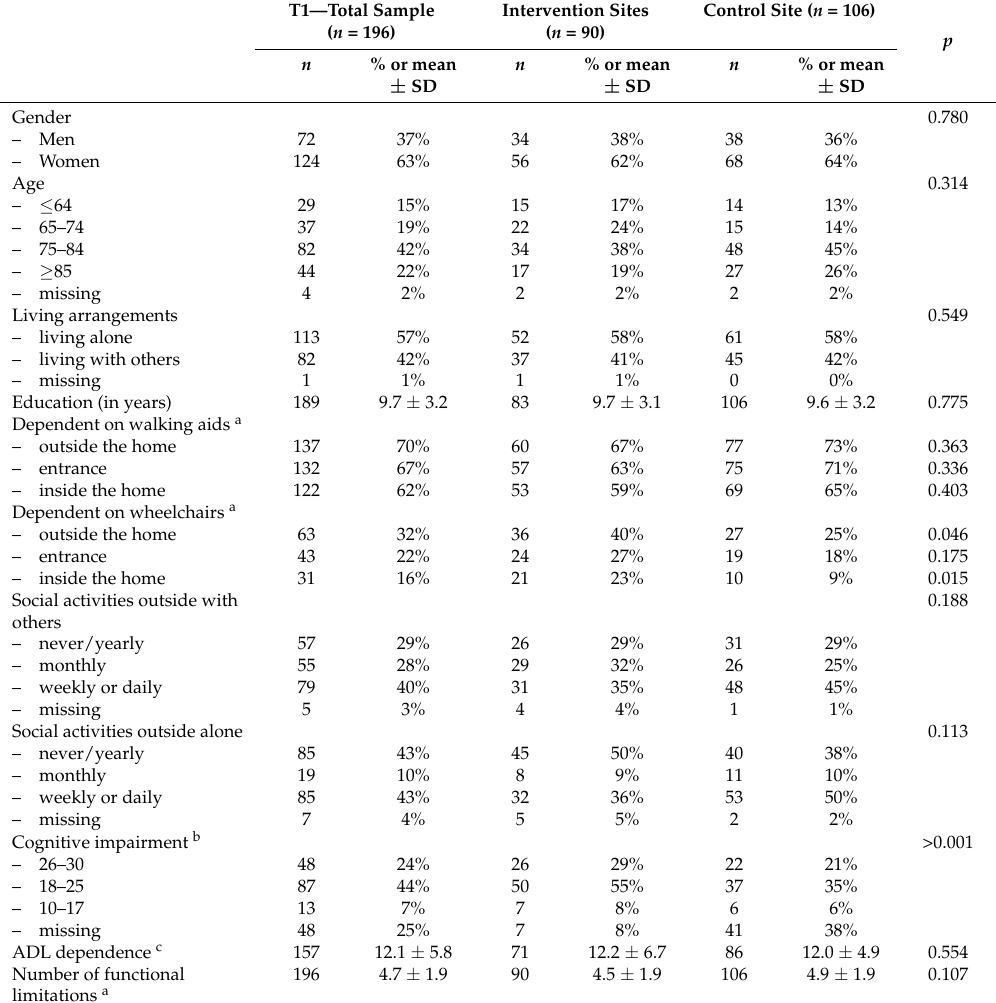
Table 1. Characteristics of the sample included in the Research Strategy for Housing Adaptation (ResHA)